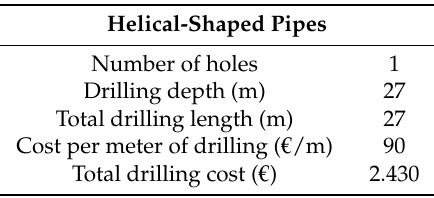
Table 7. Calculation of the geothermal drilling using helical-shaped pipes. Value provided by the Spanish company “Sondeos